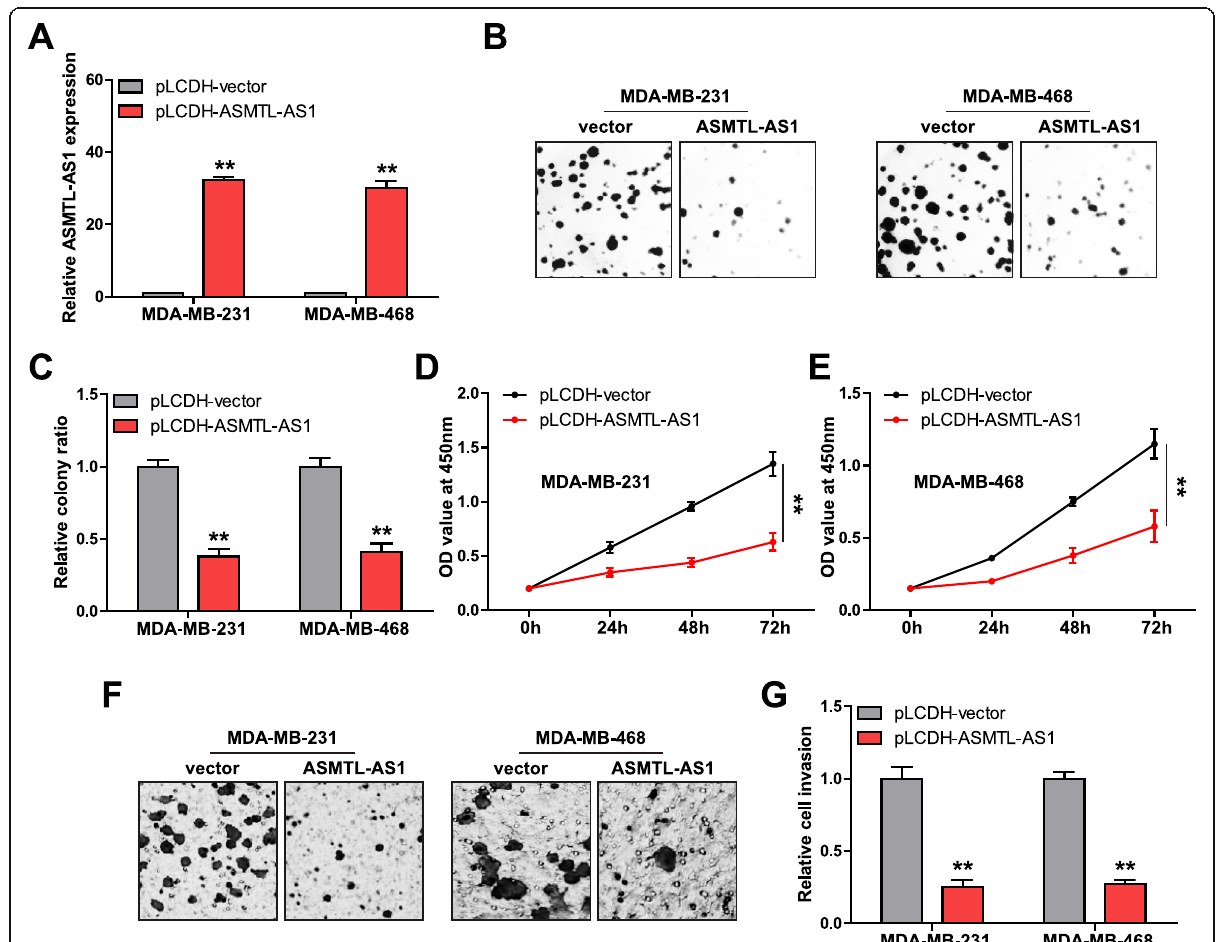
Fig. 2 Overexpression of ASMTL-AS1 inhibits TNBC cell proliferation and invasion. a . qRT-PCR verifying the overexpression efficiency in two TNBC cells. b , c . The colony rate of TNBC cells after ASMTL-AS1 overexpression. d - g . CCK-8 and Transwell assays testing cell viability and invasion after ASMTL-AS1 overexpression, respectively. ** P <